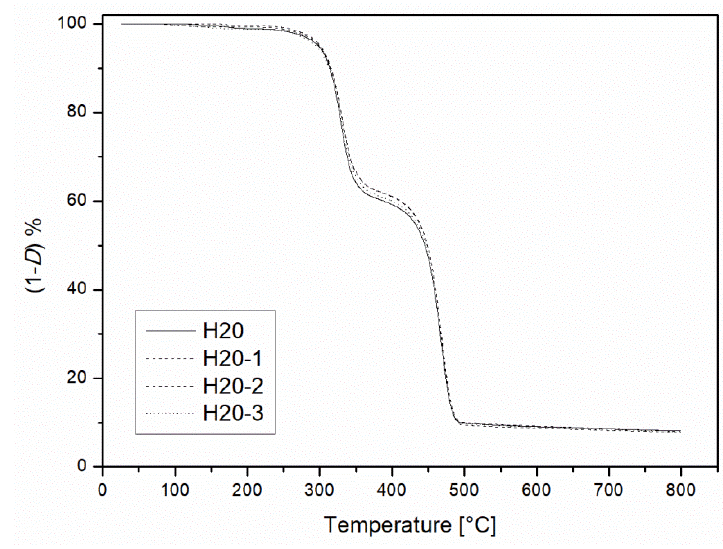
Figure 16. Thermal gravimetric results of the H20 blends as a function of the recycling cycle.